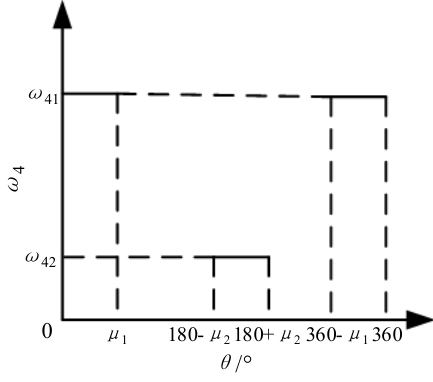
Figure 2 . The desired motion law of the output member. Figure 2. The desired motion law of the output